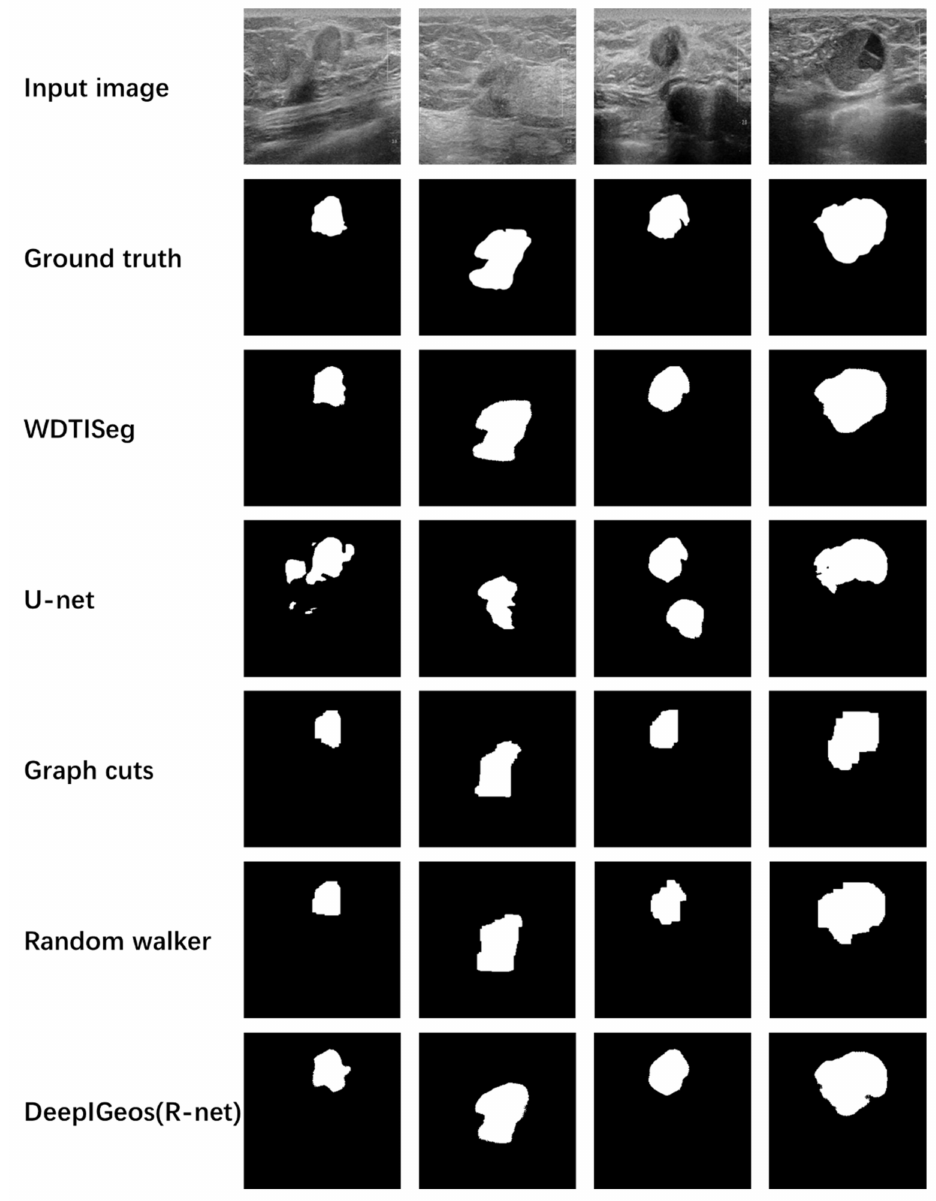
Figure 8. Visual comparison for breast ultrasound image segmentation. All results were the final result accepted after 8